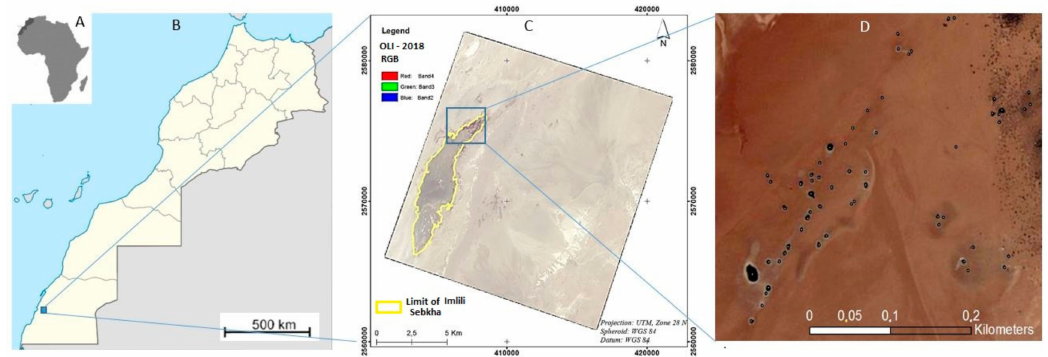
Figure 2. Location of Imlili Sebkha and its saltwater cavities. ( A ) Morocco, ( B , C ) location of sebkha, ( D ) prospected part of sebkha containing several water holes as viewed from Google Earth (16 January 2018).